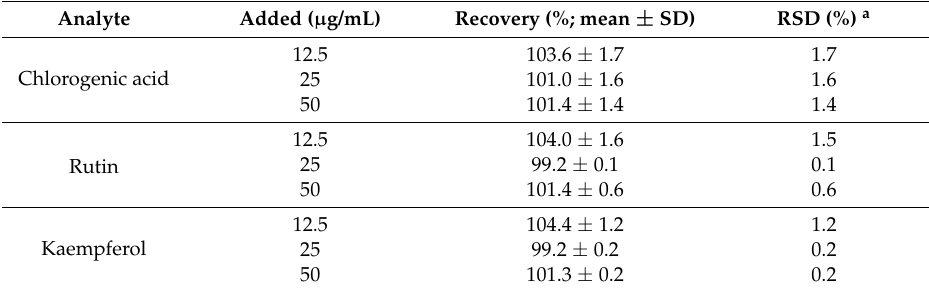
Table 4. Analytical data of recovery ( n = 6).